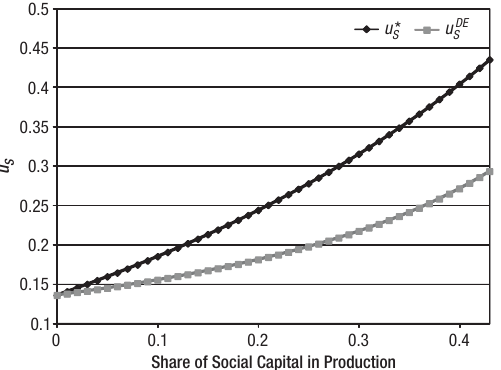
Fig. 2. Comparison between DE